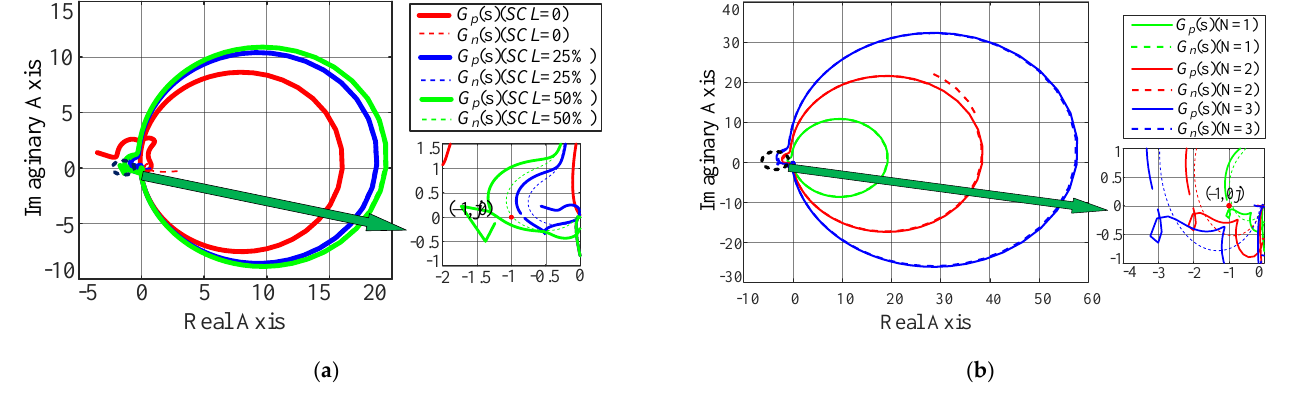
Figure 4. Nyquist Plots of (19), ( a ). Different SCL , ( b ) different number N of parallel inverter.